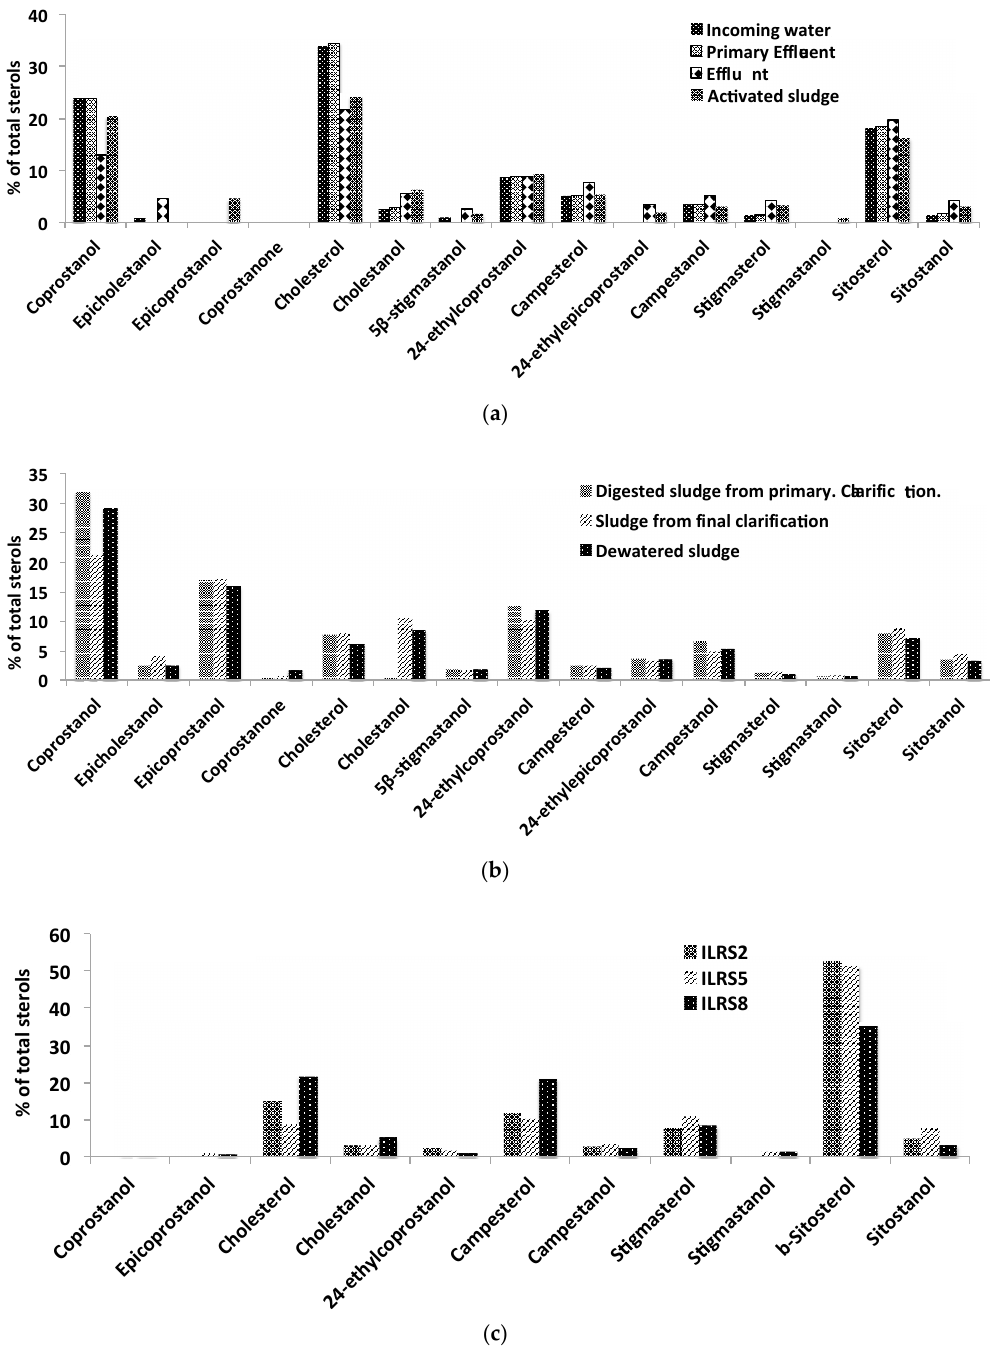
Figure 2. Sterol distribution of ( a ) the Norman WWTP water plus high water content, and ( b ) sludge samples, and of ( c ) the Illinois River samples. “ILR”: Illinois River.